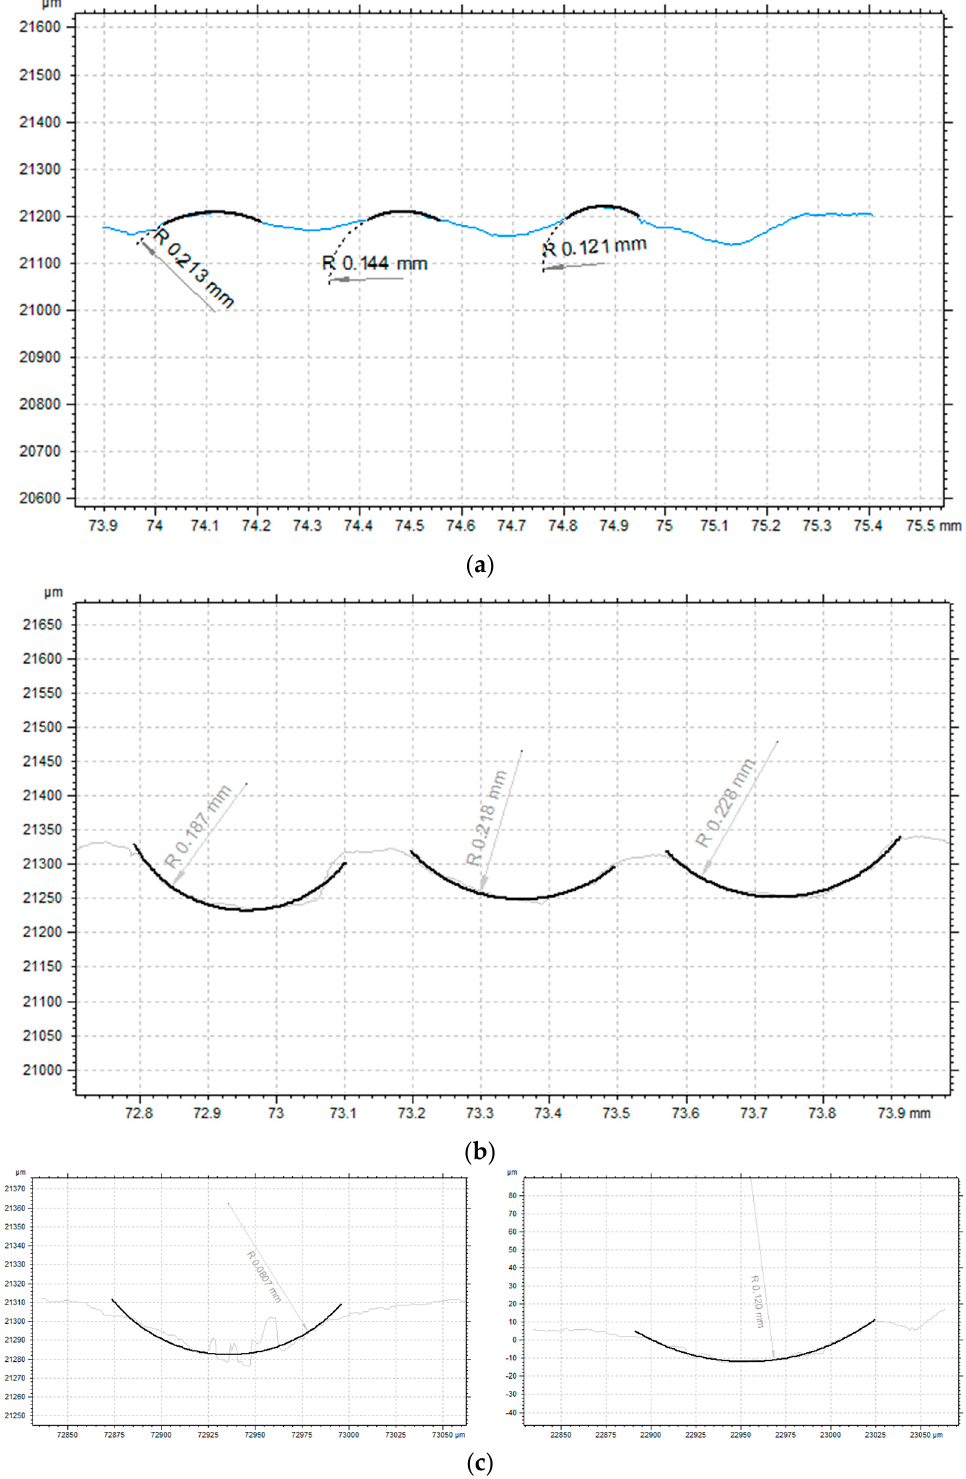
Figure 9. Example surface profile with defined values of the radius of morphological features ( a